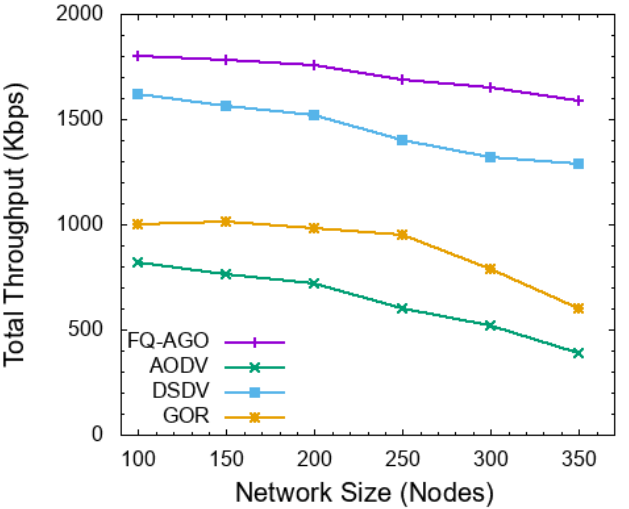
Figure 11. Total throughput vs. number of nodes.